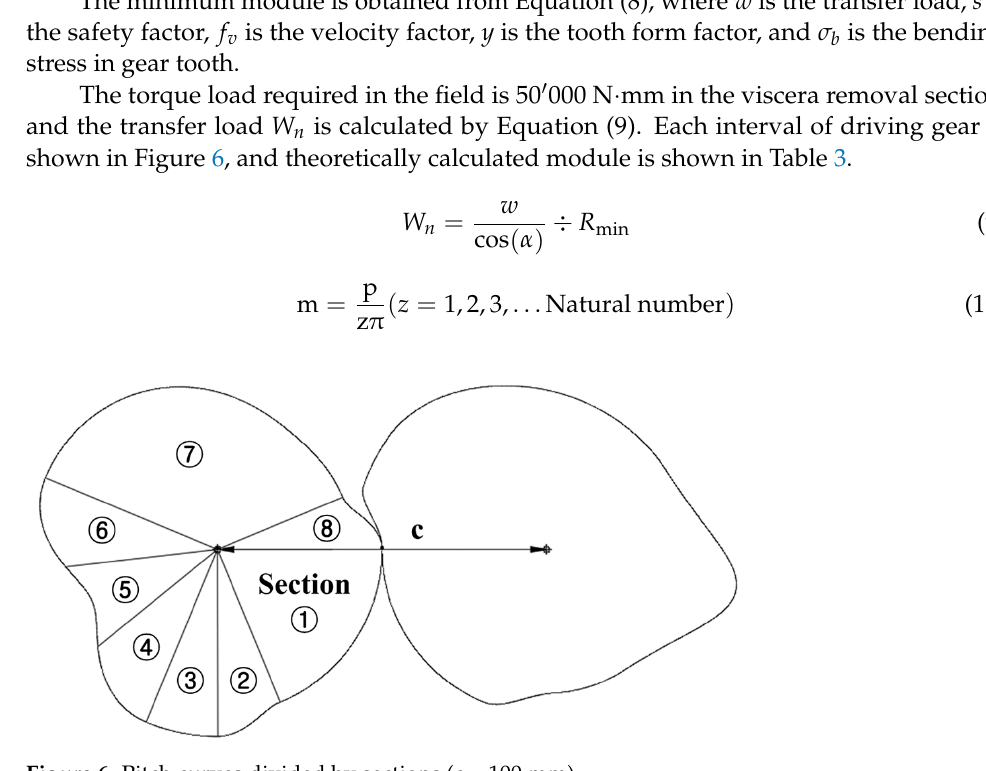
Figure 6. Pitch curves divided by sections (c = 100 mm). Table 3. Tooth profile design according to each